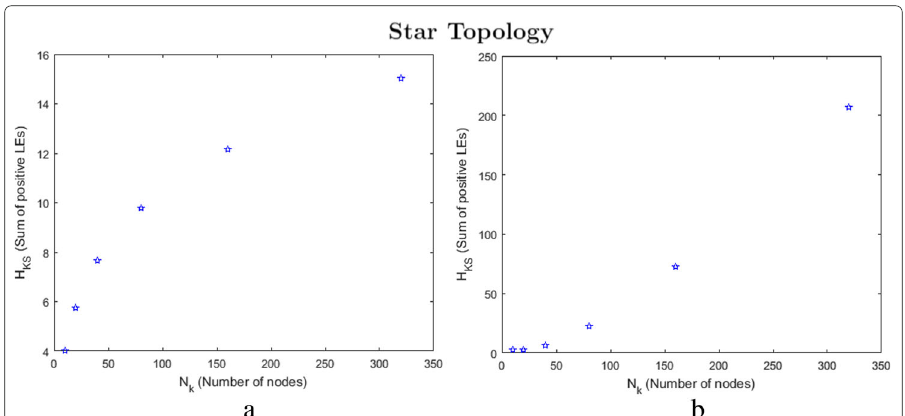
Fig. 5 The sum of positive LEs with respect to the number of nodes for networks with star topology that do not satisfy cases 1 and 2, respectively. For each network we considered the building block with N 0 = 5 and ε = 0.19. In ( a ) the inter-coupling of the network (cid:2) ( 1 ) is γ( 1 ) = 0.2 and in ( b ) γ( 1 ) = 0.6 and k = [1,2, ... ,6]. In both graphs, during the evolutionary process the inter-coupling strength was kept